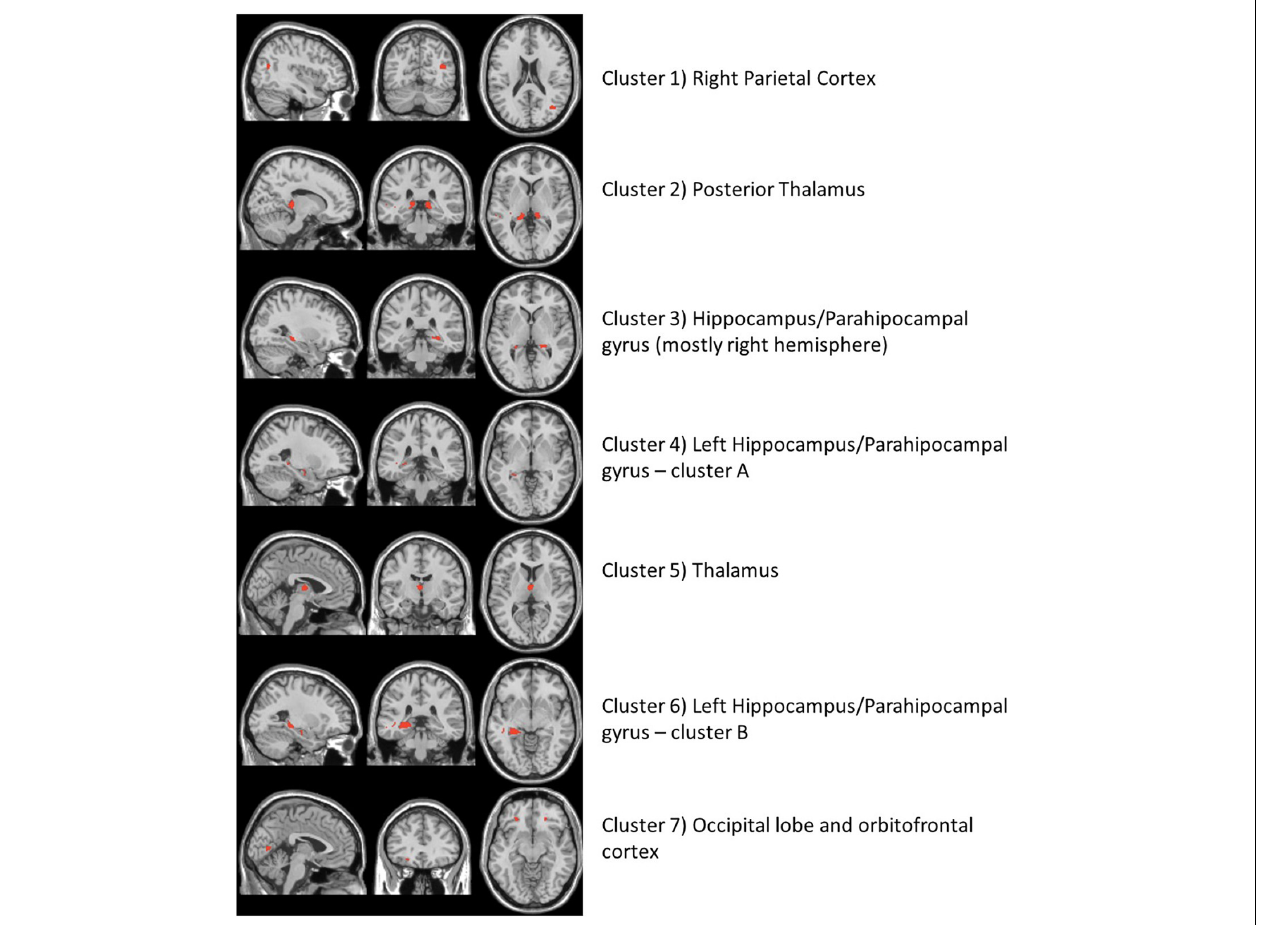
FIGURE 2 | The neuroimaging atlas of the seven annotated brain regions as identified by the imaging metabolite clusters from the multiomics network algorithm, xMWAS. The red coloring shows the location of imaging voxels for each